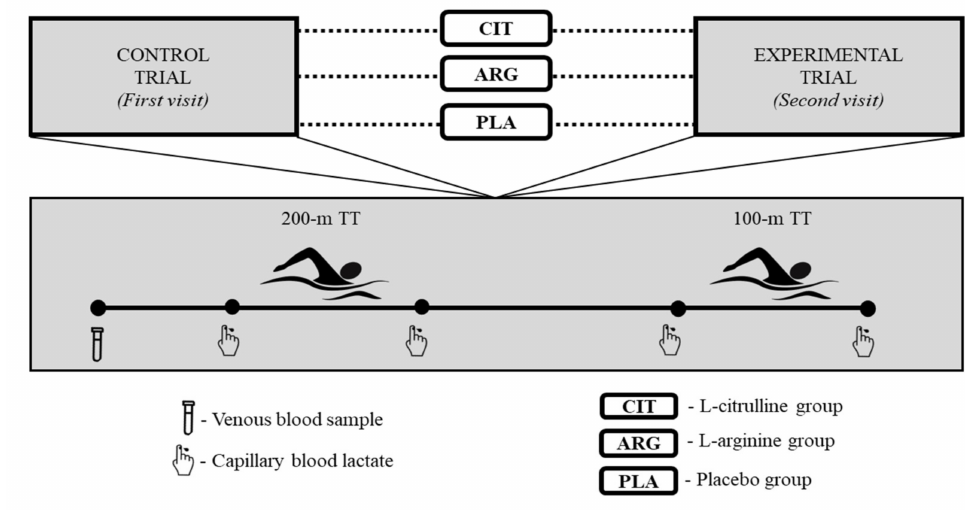
Figure 1. Experimental design.